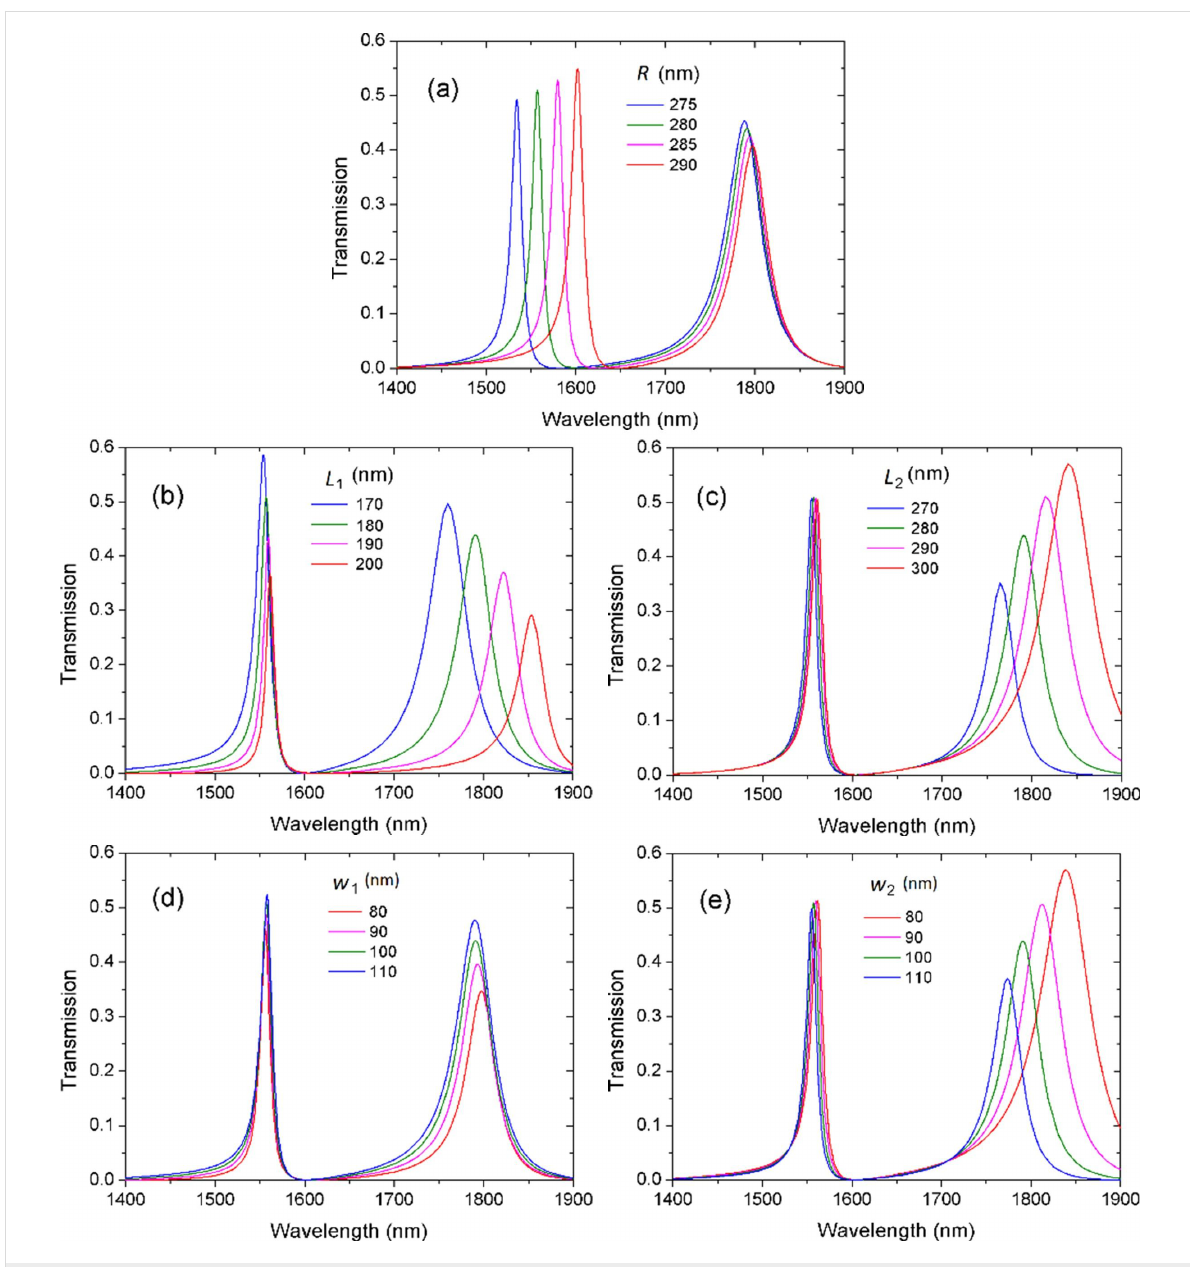
Figure 4: Transmission spectra as functions of the structural parameters: (a) radius of disk R ; (b) length of upper stub L 1 ; (c) length of lower stub L 2 ; (d) width of upper stub W 1 ; (e) width of lower stub W 2 .